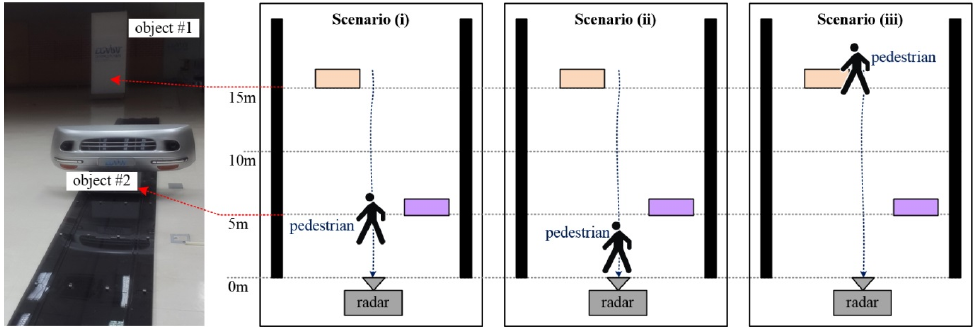
Figure 7. Configuration of the three measurement scenarios for the laboratory test.